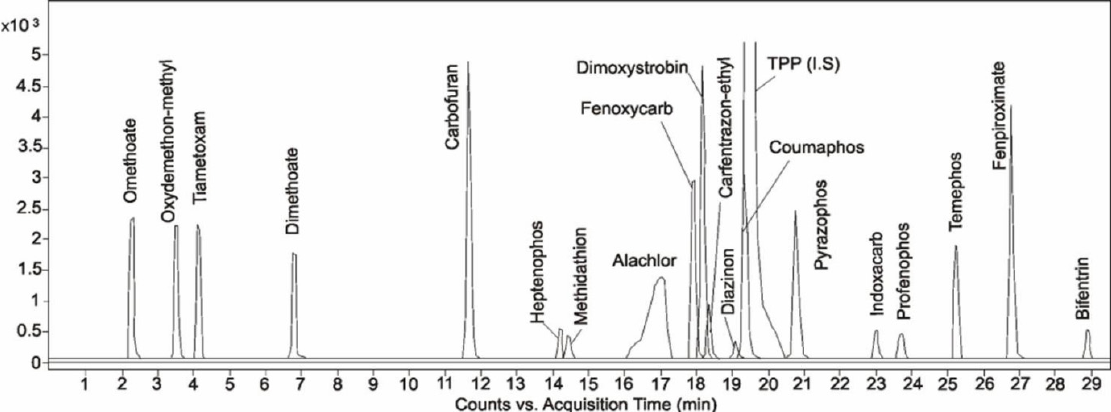
Figure 2. Sample MRM chromatograms of honeybee sample spiked with pesticides at concentration level of 3LOQ.